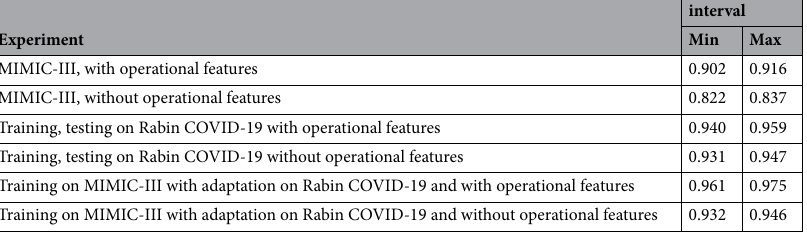
Table 3. Confidence intervals for AUC in considered experiments. AUC 95% confidence intervals were estimated by splitting the sets of patients 30 times in random. Confidence intervals were tight, meaning the prediction level remained stable across the different